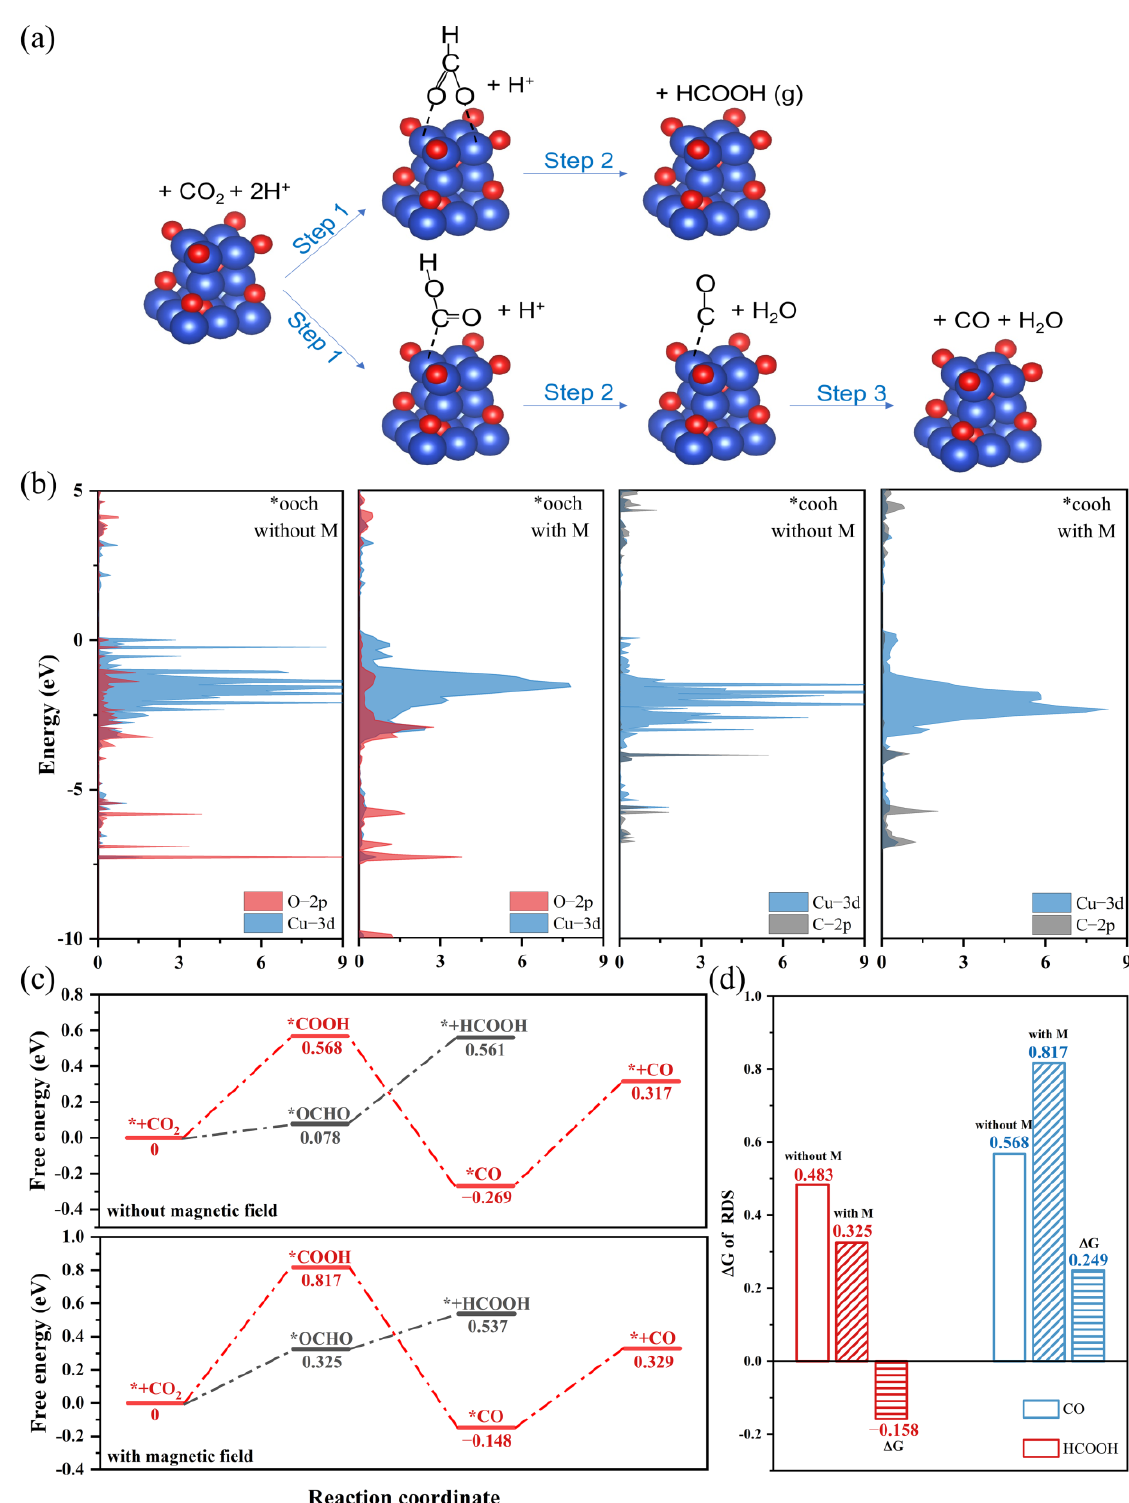
Figure 4. ( a ) Schematic diagram of the HCOOH and CO reaction paths. ( b ) Projected density of the states (PDOS) of the Cu 2 O (111) with adsorbed COOH and OCHO. The Fermi level is referenced at 0 eV. ( c ) Free energy diagrams for the CO 2 RR to CO and HCOOH on spin-polarized and unspin- polarized Cu 2 O (111) crystal surfaces. ( d ) The ∆ G of RDS for the HCOOH and CO reaction paths. The blank, slash-filled and horizontal-filled columns represent the ∆ G values of RDS on spin-polarized and unspin-polarized catalysts and the difference in values, respectively.